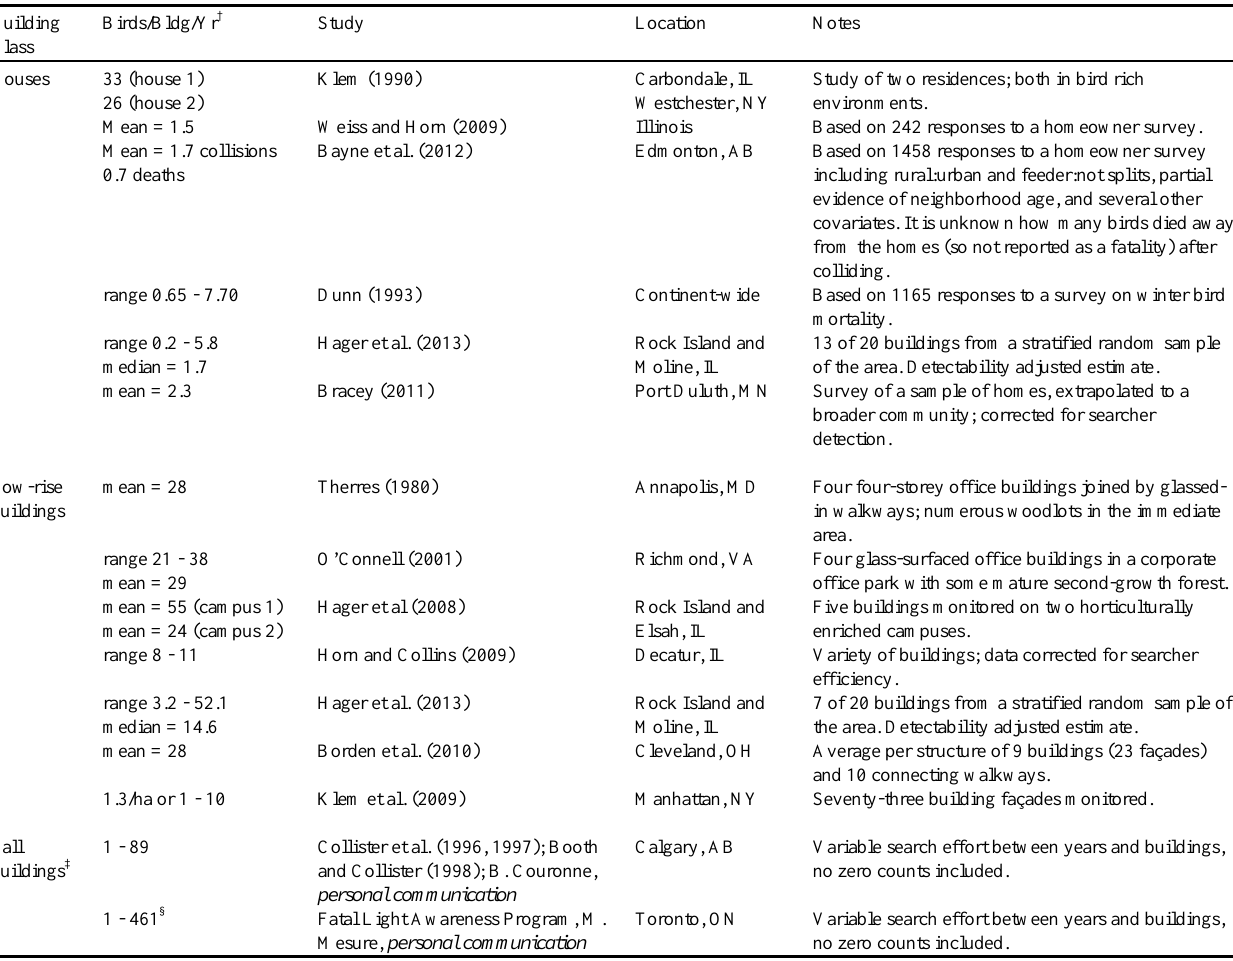
Table 1 . Rates of birds killed per building per year from studies of homes, low-rise, and tall